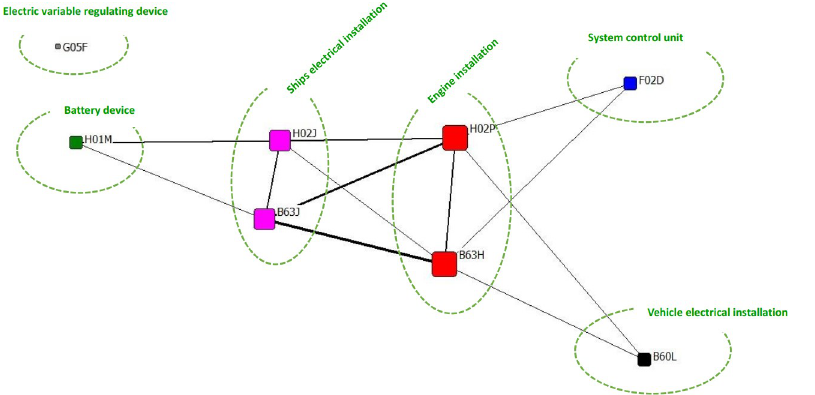
Fig 7. FJIE-C patented co-occurrence network